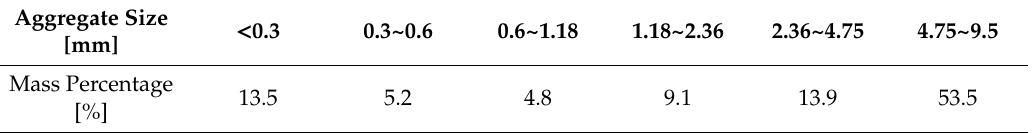
Table 1. The mass percentage of